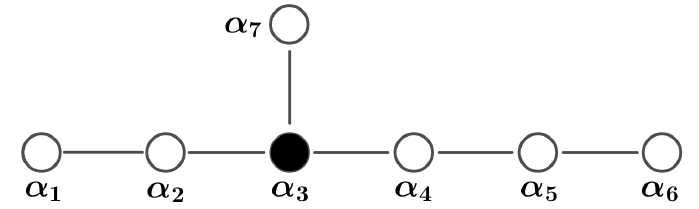
Figure 5 . E 7 Dynkin diagram, with the root blown up in the length four flop colored in black. which perfectly coincides with the results of